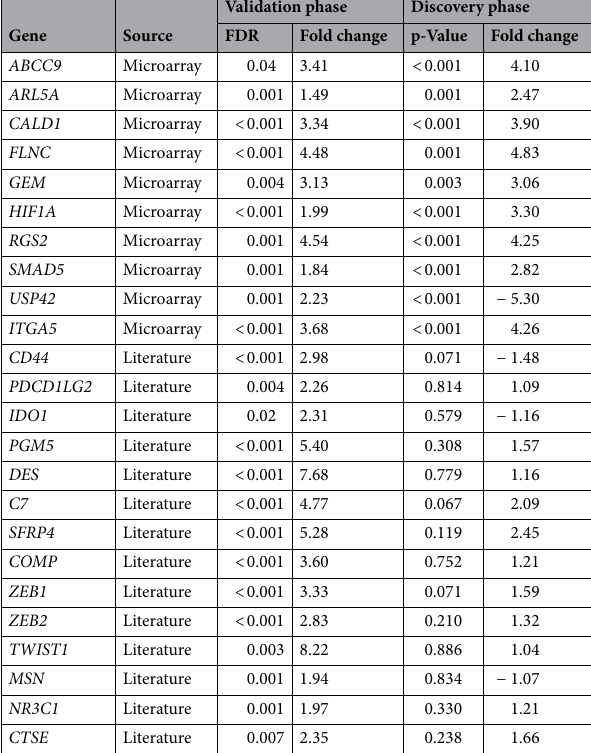
Table 2. Significant DEGs between progressive and de novo MIBC of validation phase (RT-qPCR) and comparison with fold change in genes from the discovery phase (Microarray). The source from what the gene was taken (microarray/literature) is also shown. FDR False Discovery